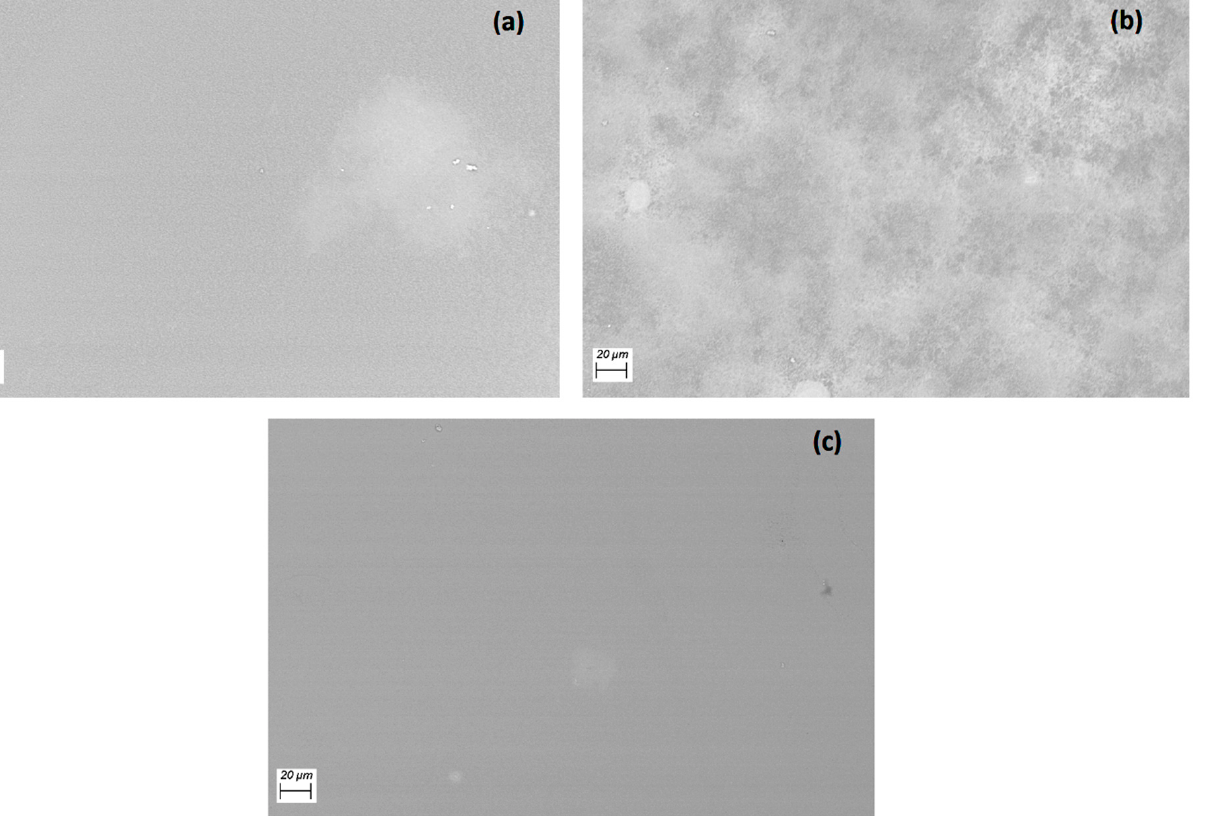
Figure 3. AFM images of ( a ) MoO 3 /PEDOT:PSS, ( b ) MoO 3 /PEDOT:PSS-A organotin (IV), ( c ) MoO 3 /PEDOT:PSS-B organotin (IV) and ( d ) MoO 3 /PEDOT:PSS-C organotin (IV) films. To enhance the information corresponding to film morphology, it is important to an- alyze their topography, since the increase in the size of the grains and roughness, along with a good continuity in the films, is a good approach to improve the transport and the mobility of charges in devices, such as organic solar cells [46]. The topography of the films